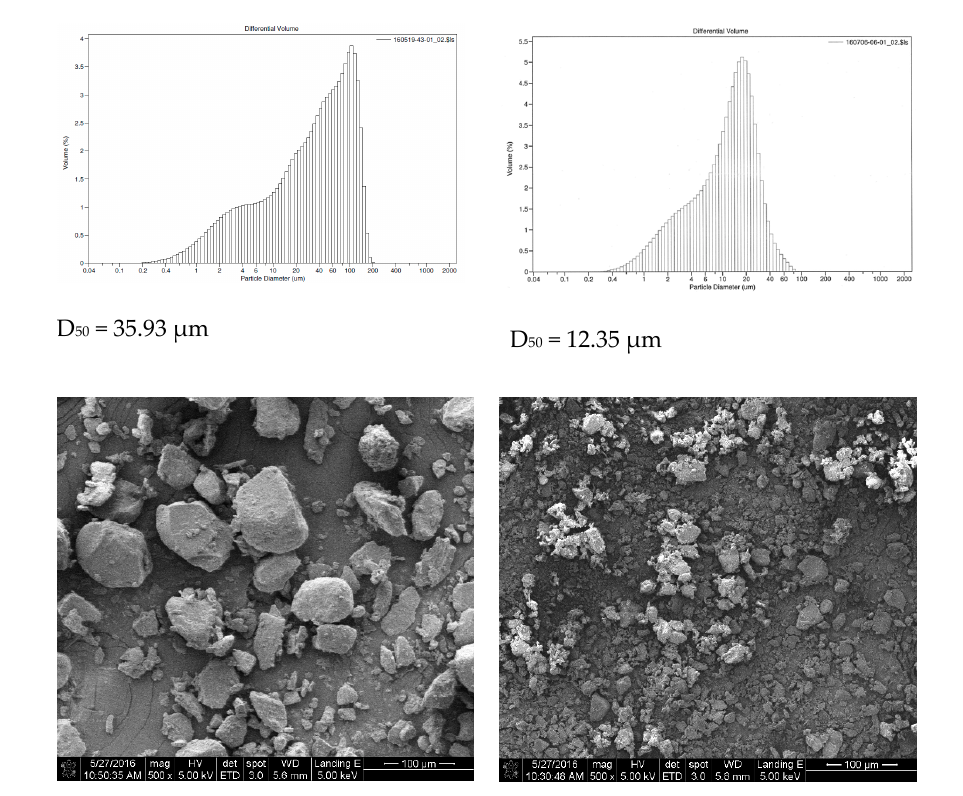
Figure 2. Particle size distribution of the HEM powder. D 50 represents the mean volumetric particle size.